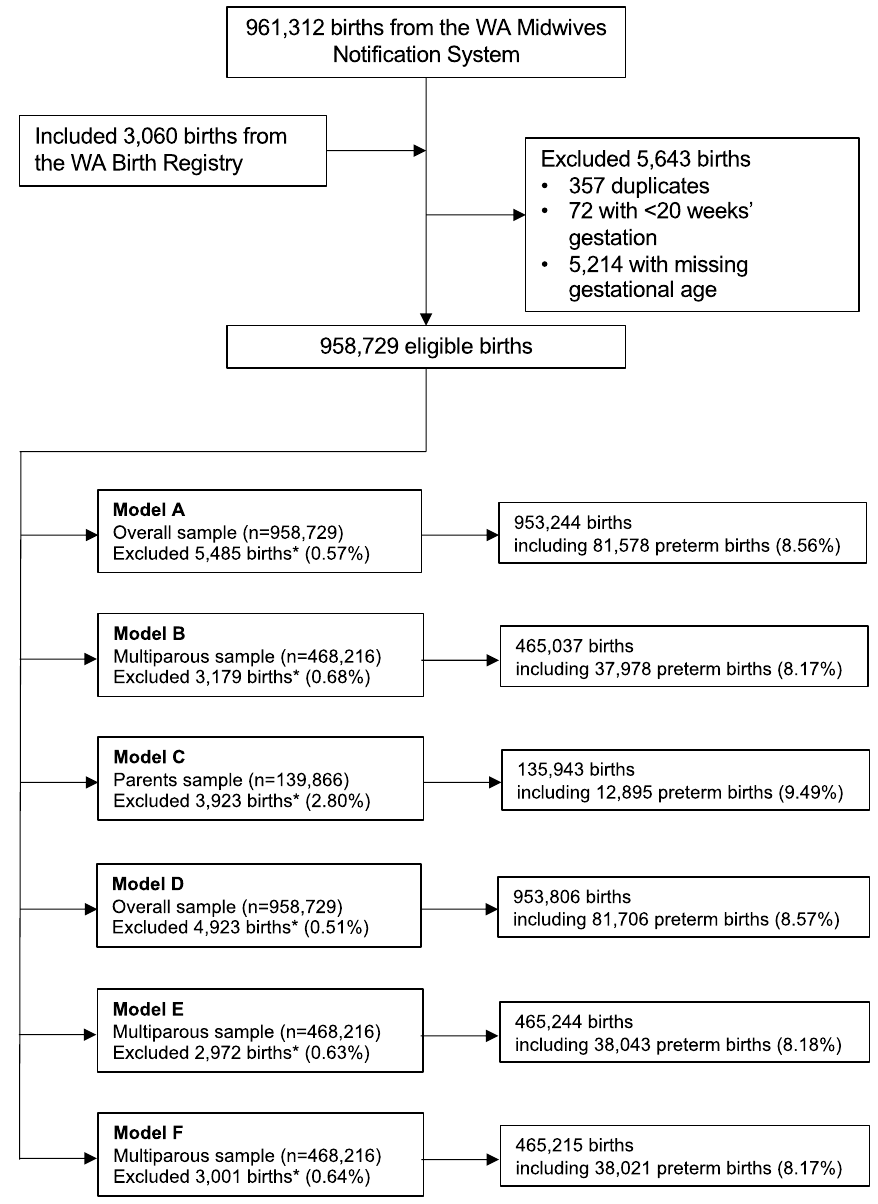
Figure 1. Study flow diagram *Births containing unknown values for a subset of predictors were excluded to reduce multicollinearity of predictors. These predictors were 1) Maternal chronic medical conditions: miscarriage ( A , B , C , D , E , F ); 2) Current pregnancy characteristics and complications: threatened preterm labour ( A , B , F ), parity ( A , B , D ), small-for-gestational age ( A , B , C ); 3) Past obstetric history: Caesarean section delivery ( B , E , F ), gestational age of the last pregnancy ( B , E , F ), small-for-gestational age ( B , E , F ); 4) Parent’s birth outcomes: preterm birth ( C ), small-for-gestational age ( C ); 5) Grandmothers’ past obstetric history: cancer registration ( C